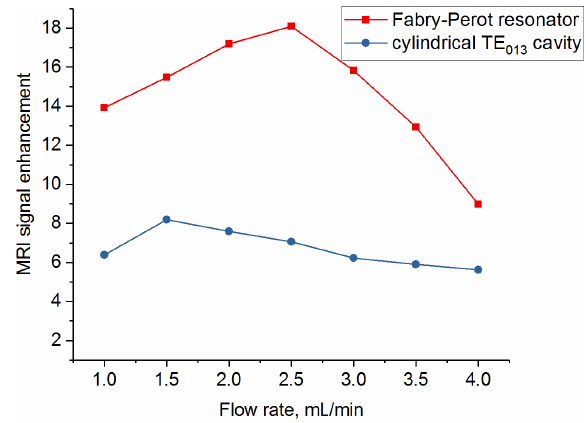
Figure 10. DNP MRI signal enhancements as a function of the flow rate. Shown are the results with the new Fabry–Pérot resonator (red) and the cylindrical cavity (blue) at a mw power of